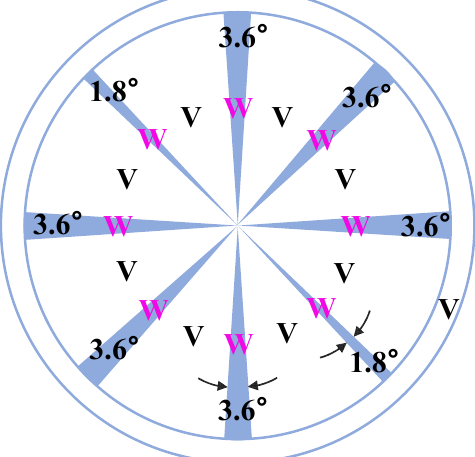
Figure 1. Schematic of the tungsten-vanadium inlaid target (when W bars are fully embedded, doping ratio-max: 7%). (The blue bar is W. One 1.8° W bar represents 0.5% doping ratio by area, and one 3.6° W bar represents 1.0% doping ratio by area; Increase the number of W bars can get different W doping concentrations, and the maximum can reach 7%.).